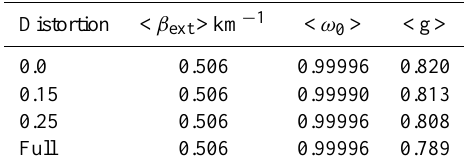
Table 1. The bulk values of < β ext >, < ω 0 >and (cid:104) g (cid:105) , calculated at the wavelength 0.865µm, for each distortion, assumed to have val- ues of 0, 0.15, 0.25 and 0.4 plus spherical air bubble inclusions (Full).